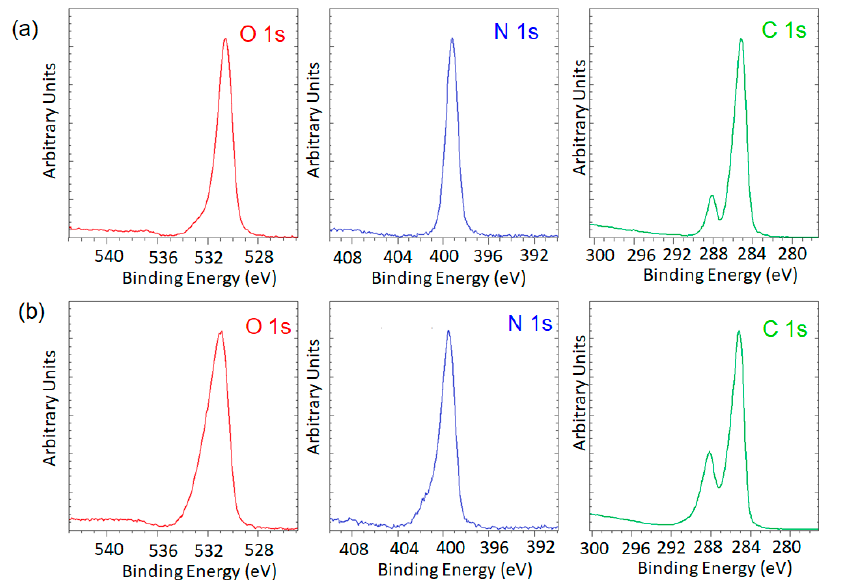
Figure 8. High-resolution XPS scans of ( a ) untreated and ( b ) 300 s He/H 2 O-plasma treated nylon films.